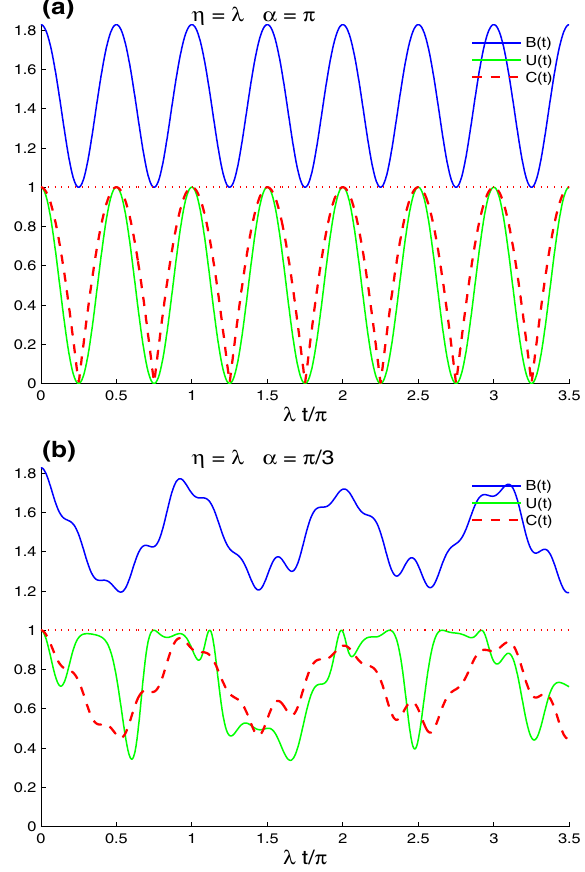
(cid:31) and the maximally correlated state: n y 1 , η = = =